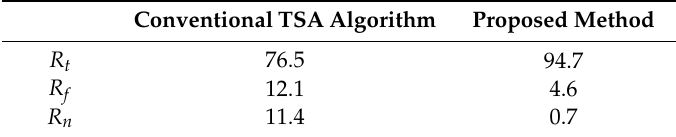
Table 3. Statistical results of track segment association based on simulation (%). TSA: track segment